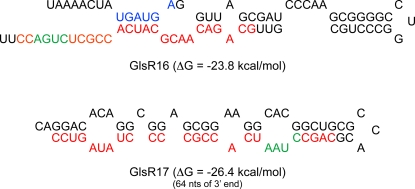
MFOLD analysis of snoRNAs GlsR16 and GlsR17.The sequences of mature snoRNA GlsR16 and the 64 nt 3′-portion of GlsR17 were submitted to the MFOLD RNA server. Both snoRNAs produced secondary structures that are suitable for being Dicer substrates. The red letters represent miR3 in GlsR16 and miR2 in GlsR17. The Box C (blue) and Box D (green) motifs are indicated. Both miRNAs are located at the 3′-end of their precursors.